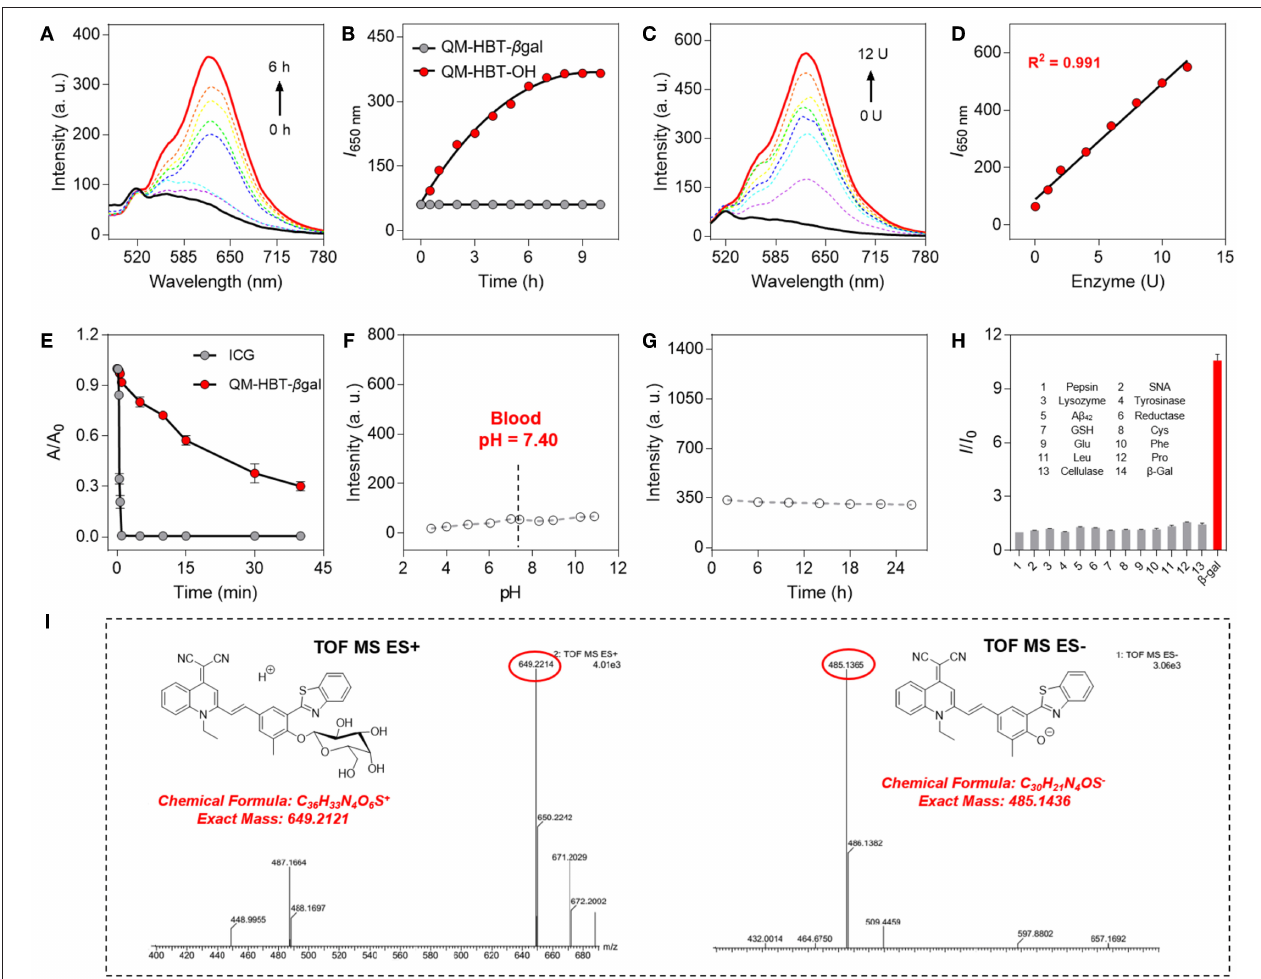
FIGURE 2 | (A) Time-dependent fluorescence spectra of QM-HBT- β gal (10 µ M) with 10U β -gal in aqueous solution (PBS/DMSO = 7:3, v/v, 50mM, pH = 7.4) at 37 ◦ C. (B) Time dependence of I 650 nm for QM-HBT- β gal before (black) and after (red) adding β -gal, λ ex = 460nm. (C) Fluorescence spectra of QM-HBT- β gal (10 µ M) upon treatment with increasing concentrations of β -gal (0–12U) after incubation for 6h. (D) Fluorescence intensity I 650 nm as a function of β -gal concentration after incubation for 6h. (E) Time-dependent fluorescence intensity of ICG (10 µ M, monitored at 812nm, and λ ex = 780nm) and QM-HBT- β gal (10 µ M, monitored at 650nm, and λ ex = 460nm) under sustained illumination. (F) Fluorescence intensity at 650nm of QM-HBT- β gal remaining stable in various pH values and (G) fresh mouse serum over 24h at 37 ◦ C. (H) Fluorescence responses of QM-HBT- β gal (10 µ M) upon incubation with β -gal (10U) and various other analytes (100 equiv.) in aqueous solution (PBS/DMSO = 7:3, v/v, 50mM, pH = 7.4) at 37 ◦ C, λ ex = 460nm. (I) High-resolution mass spectrometry (HRMS) demonstrating the enzyme-activatable mechanism and showing the cleavage product QM-HBT-OH.